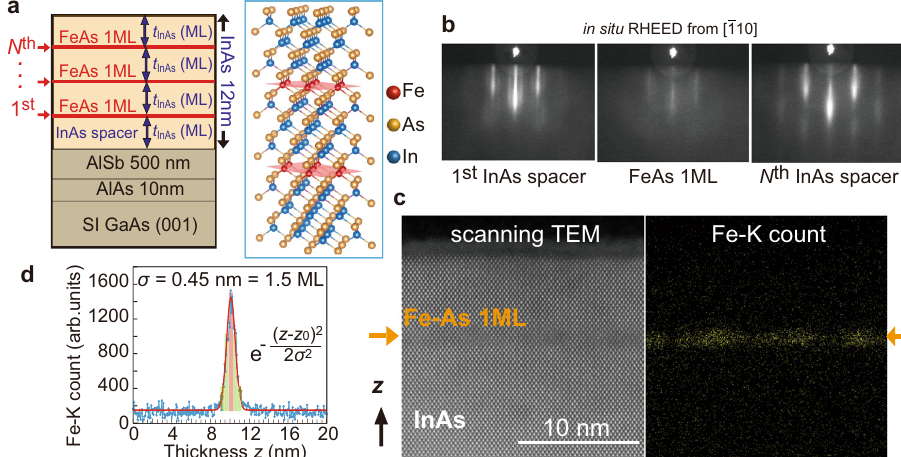
Fig. 1 Crystal growth of FeAs/InAs SL structures. a Schematic sample structure of the FeAs/InAs SL grown on a GaAs (001) substrate. There are N FeAs layers (red planes) embedded in an InAs matrix with a regular distance of t InAs . The total thickness of the FeAs/InAs structures is 41 – 47 MLs ( = 12.4 – 14 nm). b In situ RHEED patterns along the [ (cid:1) 110] direction during the growth of the FeAs/InAs SL in sample A4. c High-resolution scanning TEM of a sample with 1 ML FeAs embedded in InAs (left panel) and the corresponding mapping of Fe atoms by EDX (right panel). d Fe distribution along the growth direction mapped with EDX, which follows a normal distribution with a standard deviation of 0.45 nm (1.5 ML of